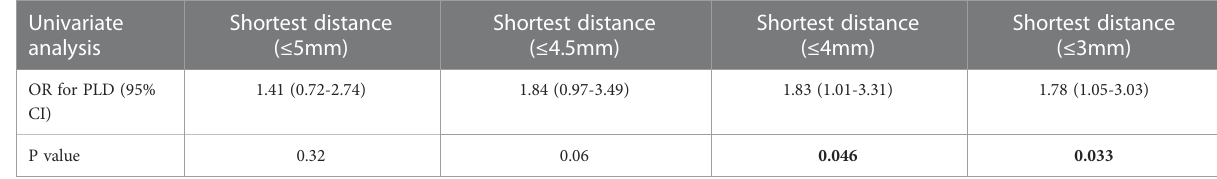
Boldface type indicated statistical signi fi